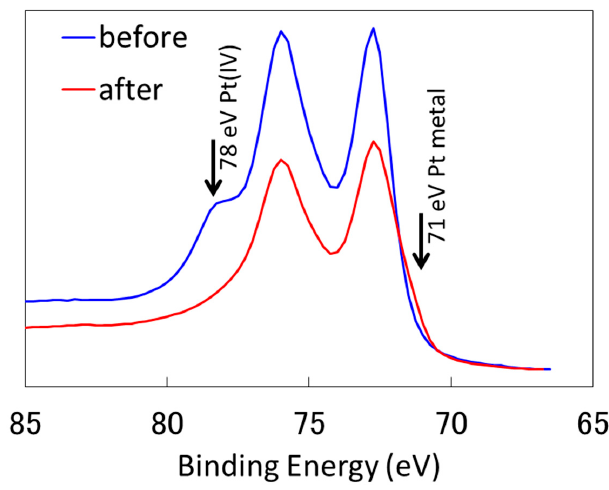
Figure 8. Pt4f5/2 XPS spectra before and after the activation treatment.